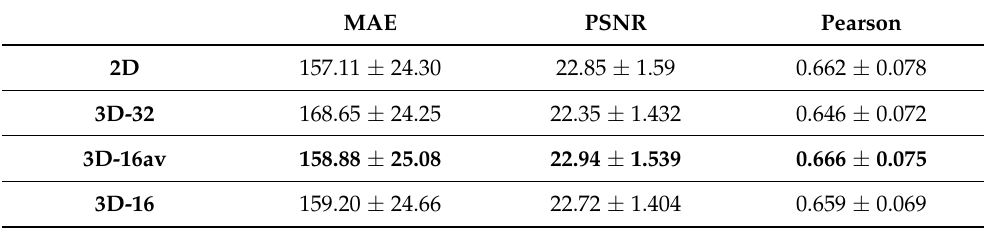
Table 9. Head dataset Fat with Residual-Net. Mean Absolute Error, PSNR and Pearson coefficient within the fat on the head data set obtained using Residual net with different convolutions and reconstructions.